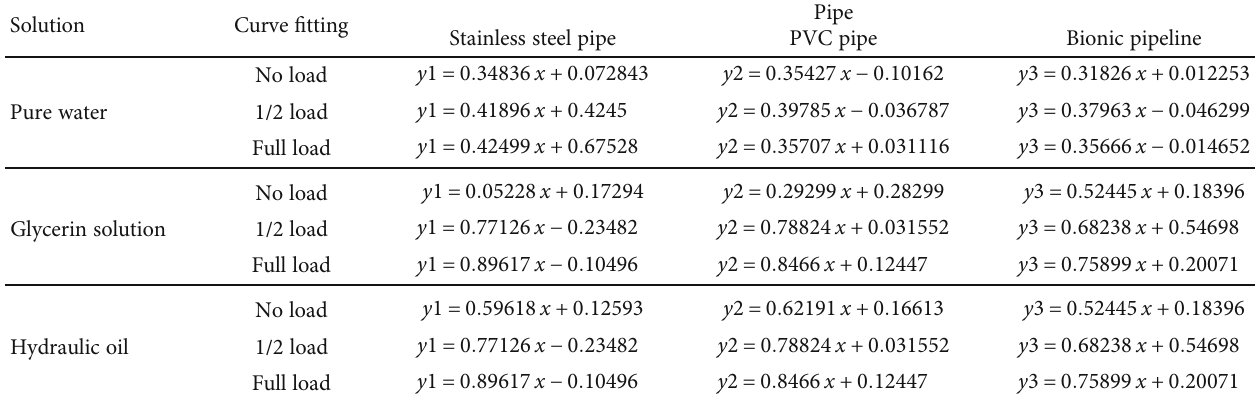
Table 4: Comparison